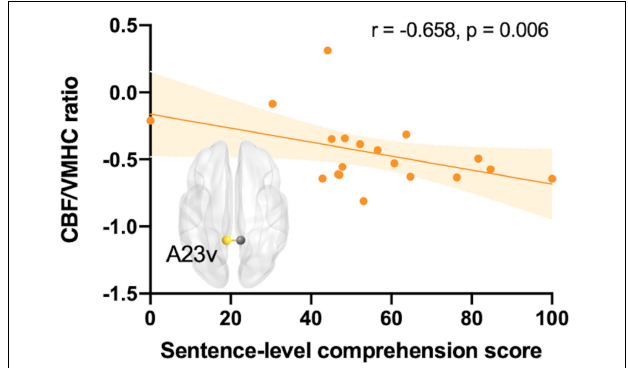
FIGURE 5 | Correlation between sentence-level speech comprehension subdomains and the regional mean CBF/VMHC ratio for the cingulate gyrus subregion (A23v) in patients with post-stroke aphasia after controlling for age, sex, education level, and lesion size (FDR-corrected p < 0.05). A23v, ventral area 23; CBF, cerebral blood flow; VMHC, voxel-mirrored homotopic